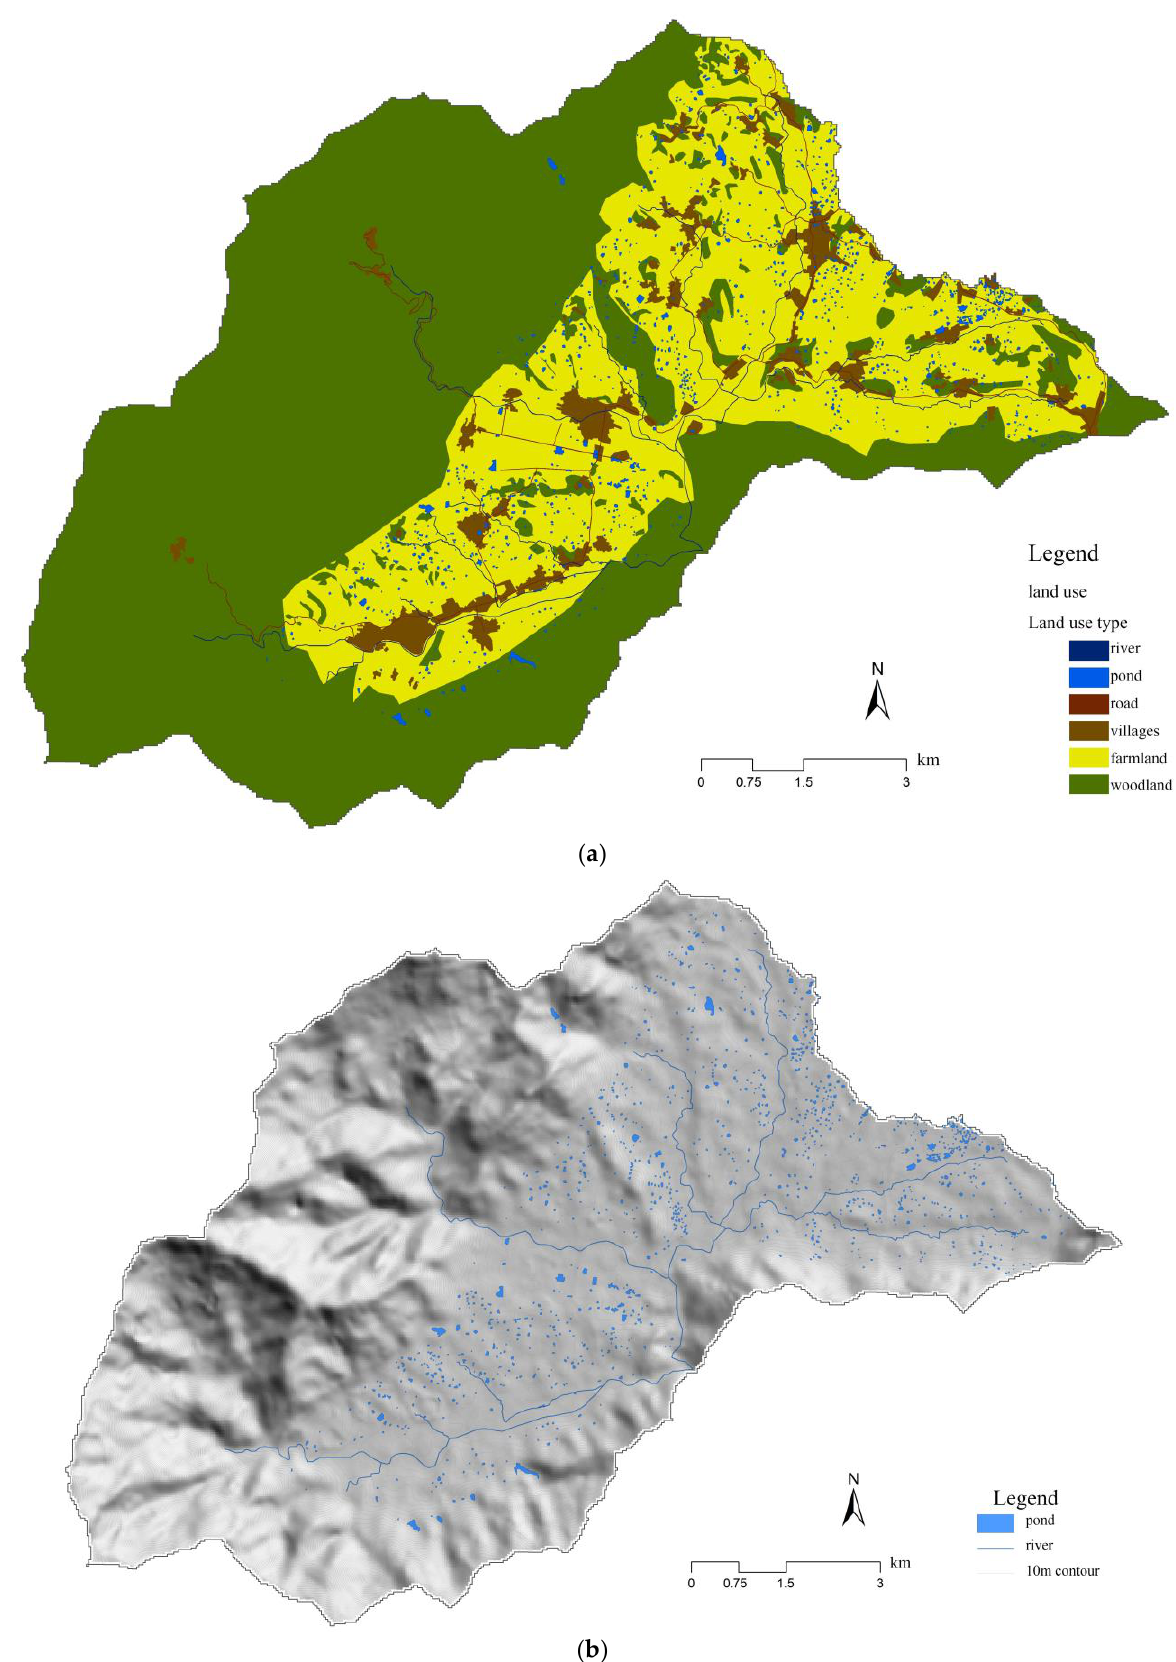
Figure 2. ( a ) Land-use dataset; ( b ) The river